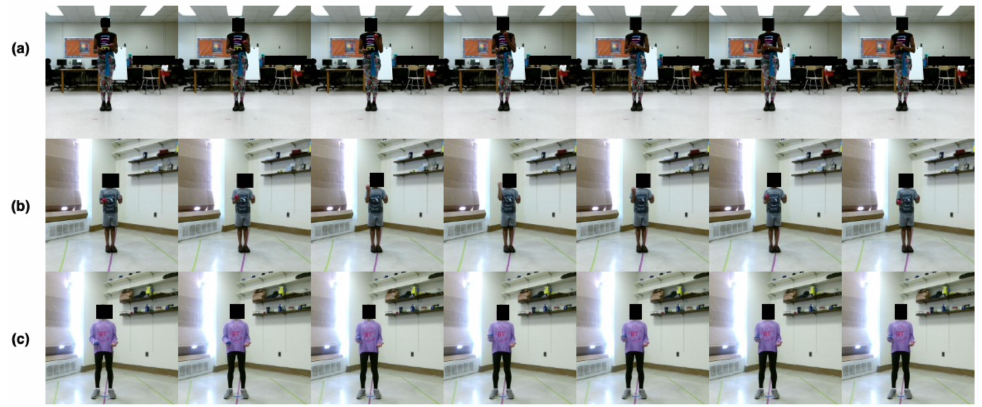
Figure 4. Samples from the Ball drop to the beat task. Each row represents a specific action carried out by the children. ( a ) Ball Pass ( b ) Hand raise ( c ) No pass [9].